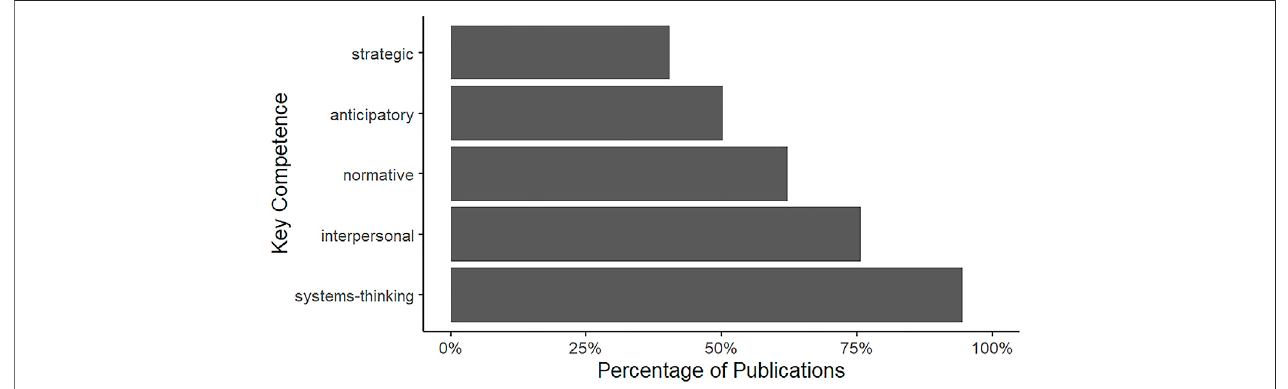
FIGURE 4 | Percentage of sampled publications ( n (cid:1) 272) on competencies that can be mapped onto the 2011 framework (1997 –